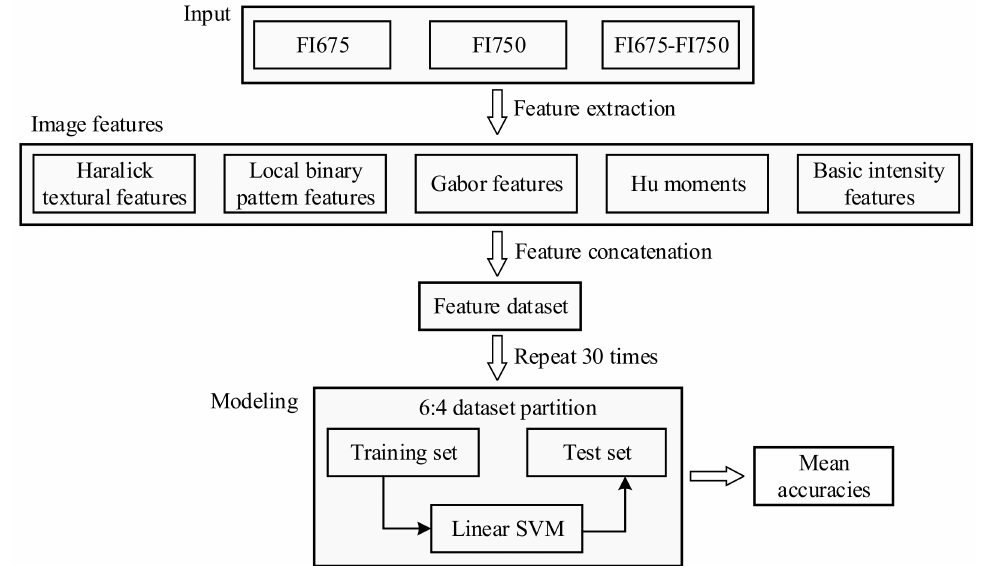
Figure 6. Machine learning procedures for building classification models using the features extracted from the fluorescence images. FI675 and FI750 denote chlorophyll fluorescent images at 675 nm and 750 nm, respectively, and SVM is short for support vector